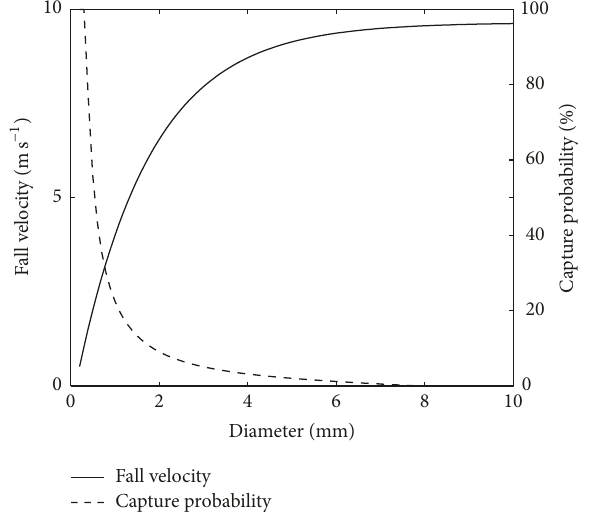
Figure 7: The capture probability of PMCS on raindrops measure- ment (with the Atlas model [12] for the rainfall